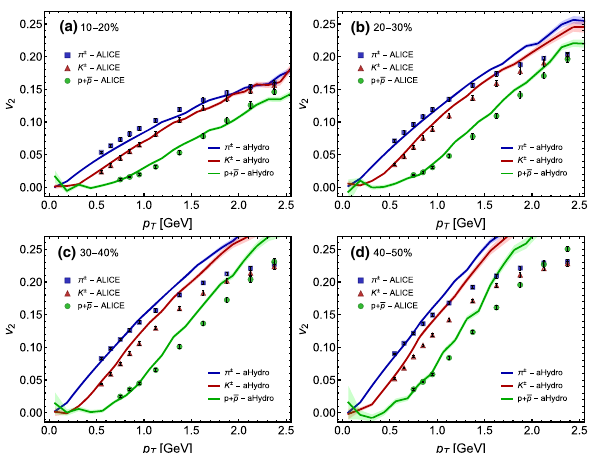
Fig. 7 Identifiedellipticflowasafunctionoftransversemomentumfor 5.02 TeV Pb–Pb collisions in different centrality classes. The solid lines are the predictions of 3+1D aHydroQP and the points are experimental results from the ALICE Collaboration [72]